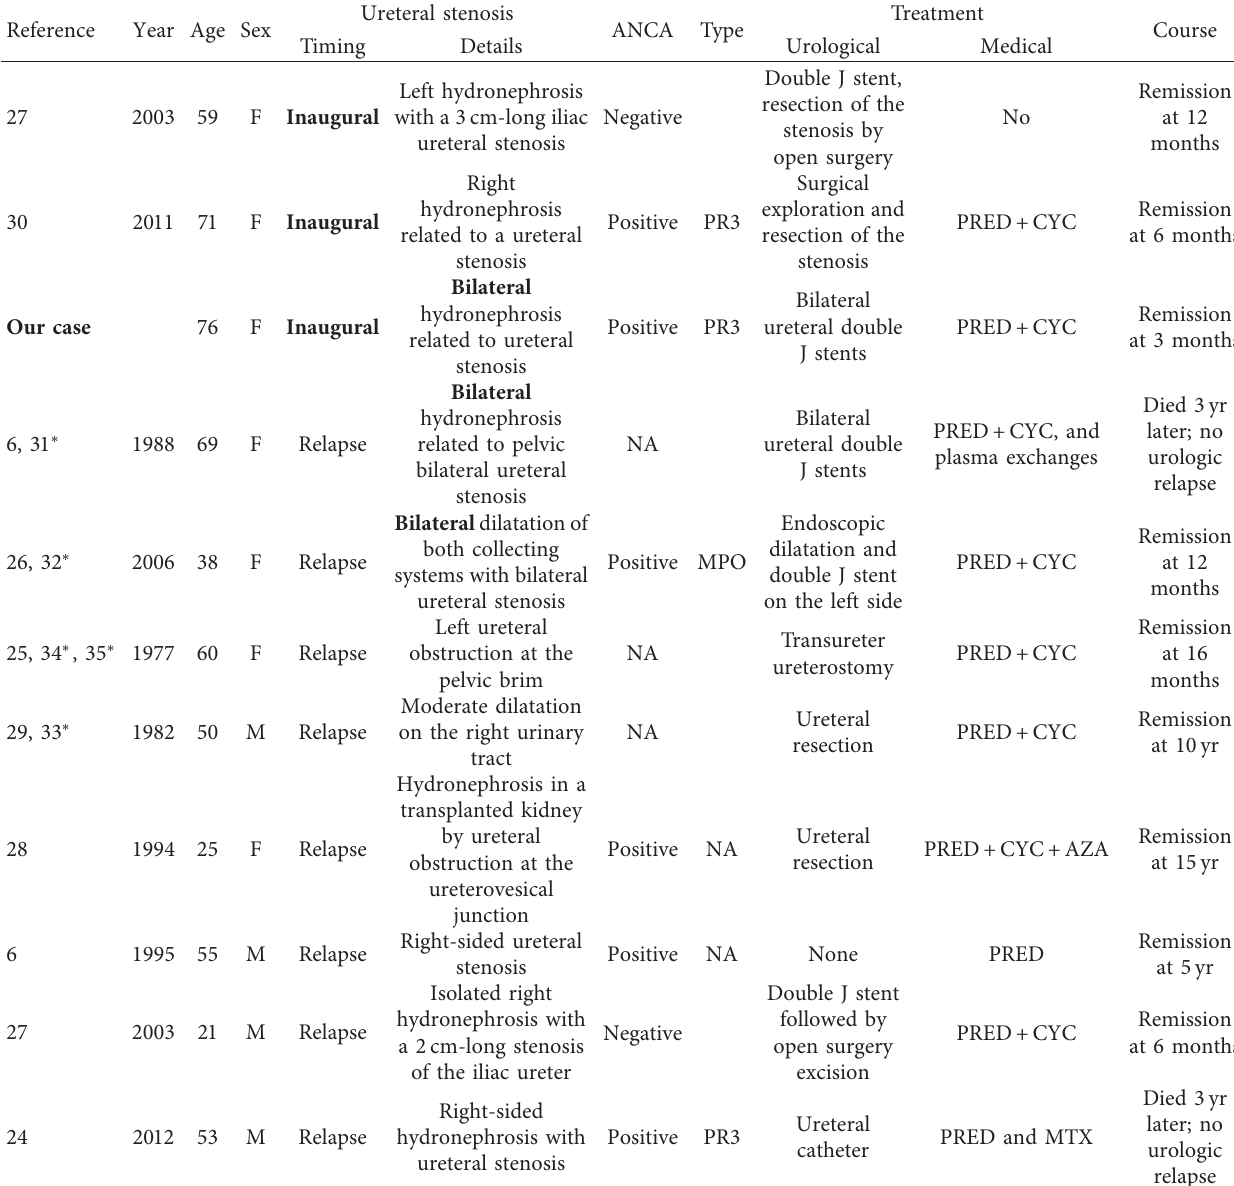
Table 3: Summary and characteristics of the reported cases of ureteral stenosis in